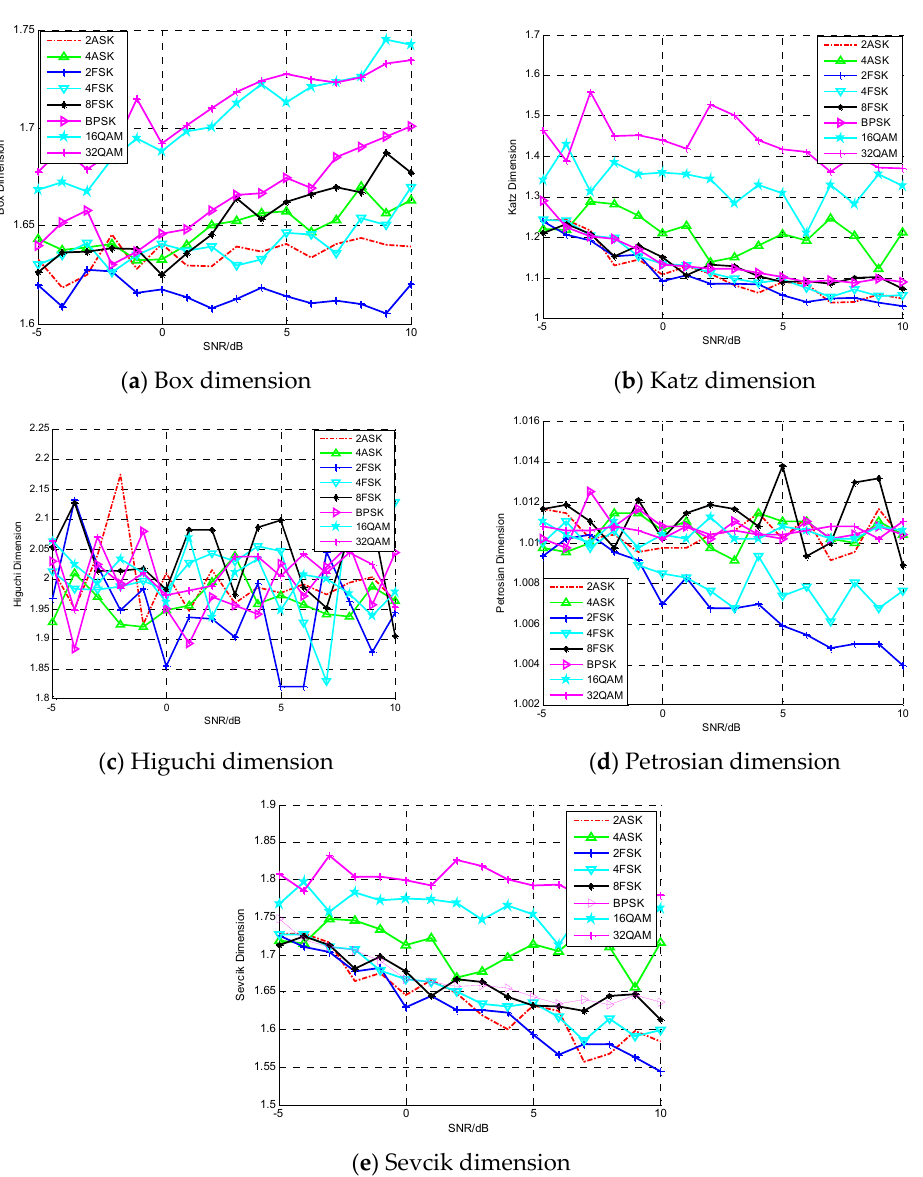
Figure 3. Fractal dimension of different communication modulation signals.